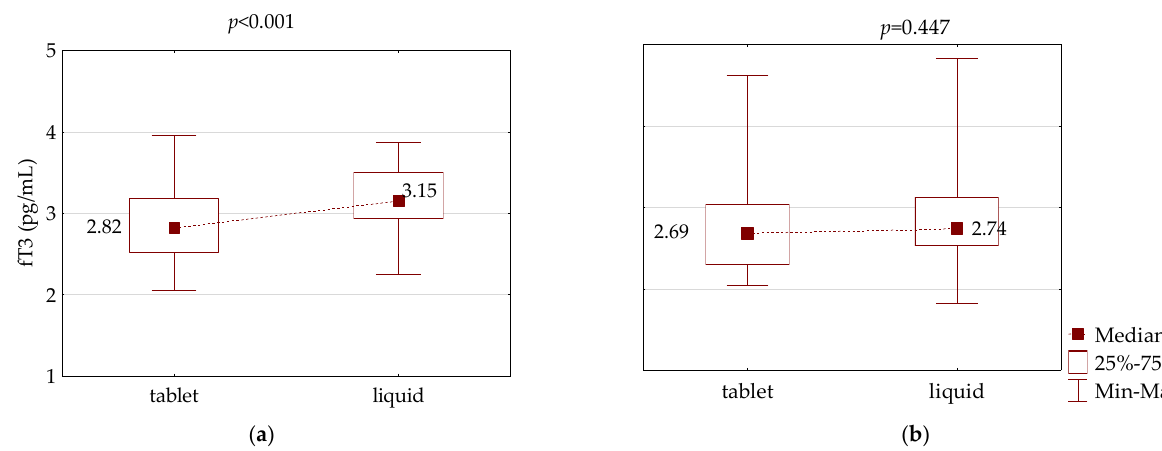
Figure 2. Comparison of fT4 serum concentration between LT4 therapy in tablet and liquid form in an equivalent dose in: ( a ) primary hypothyroidism and ( b ) central hypothyroidism.